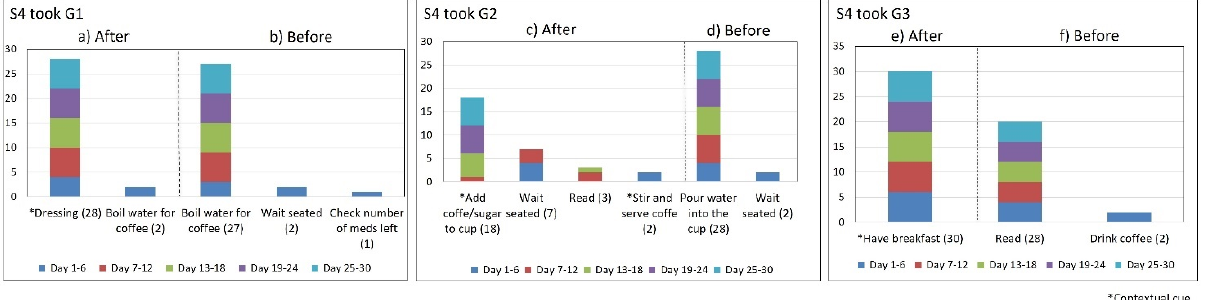
Figure 10. The number of days that S4 performed the medication episodes (G1-AM, G2-AM, and G3-AM) after and before the reported activities.